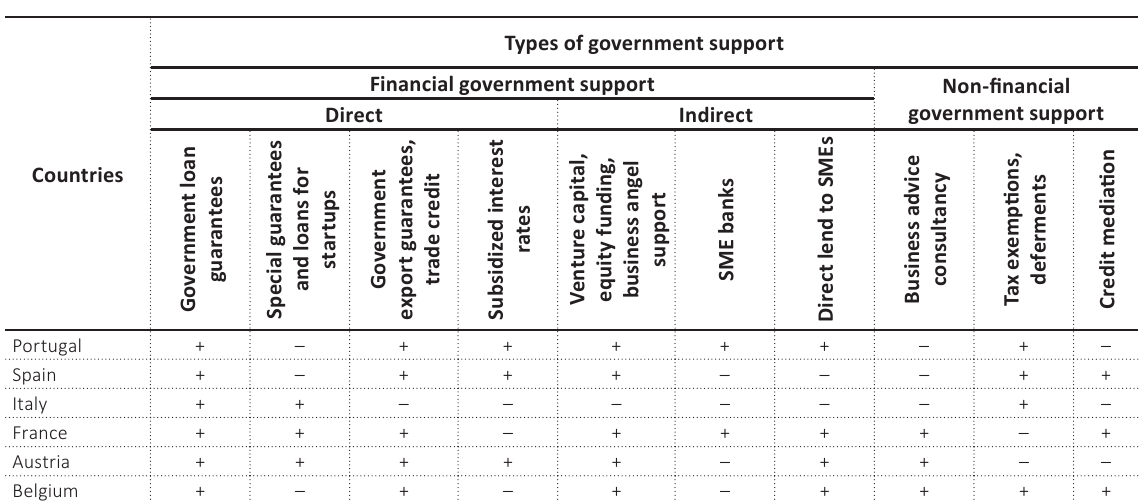
Table 3. Ways of government support for SME’s access to finance in EU countries (debt crisis period)